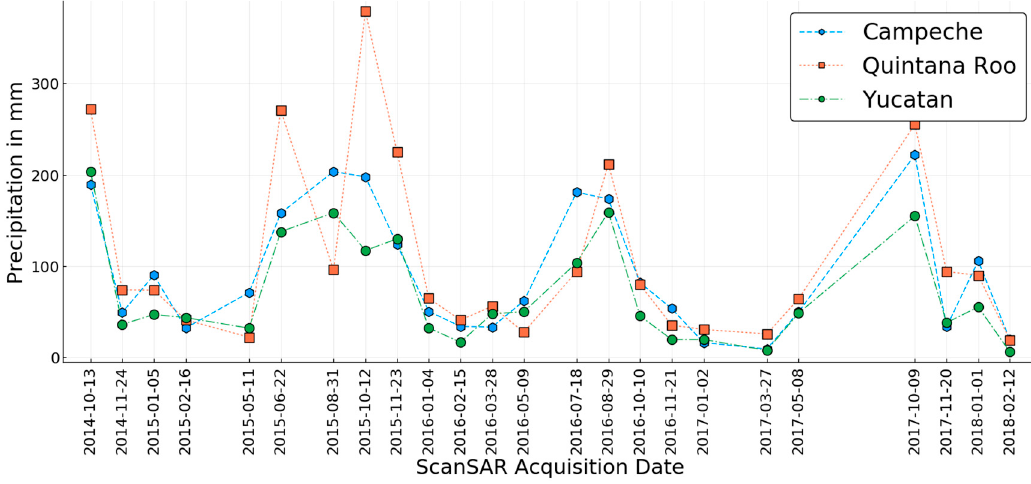
Figure 5. Acquisition dates of the ScanSAR mosaics with corresponding monthly precipitation for the three federal states from [46].